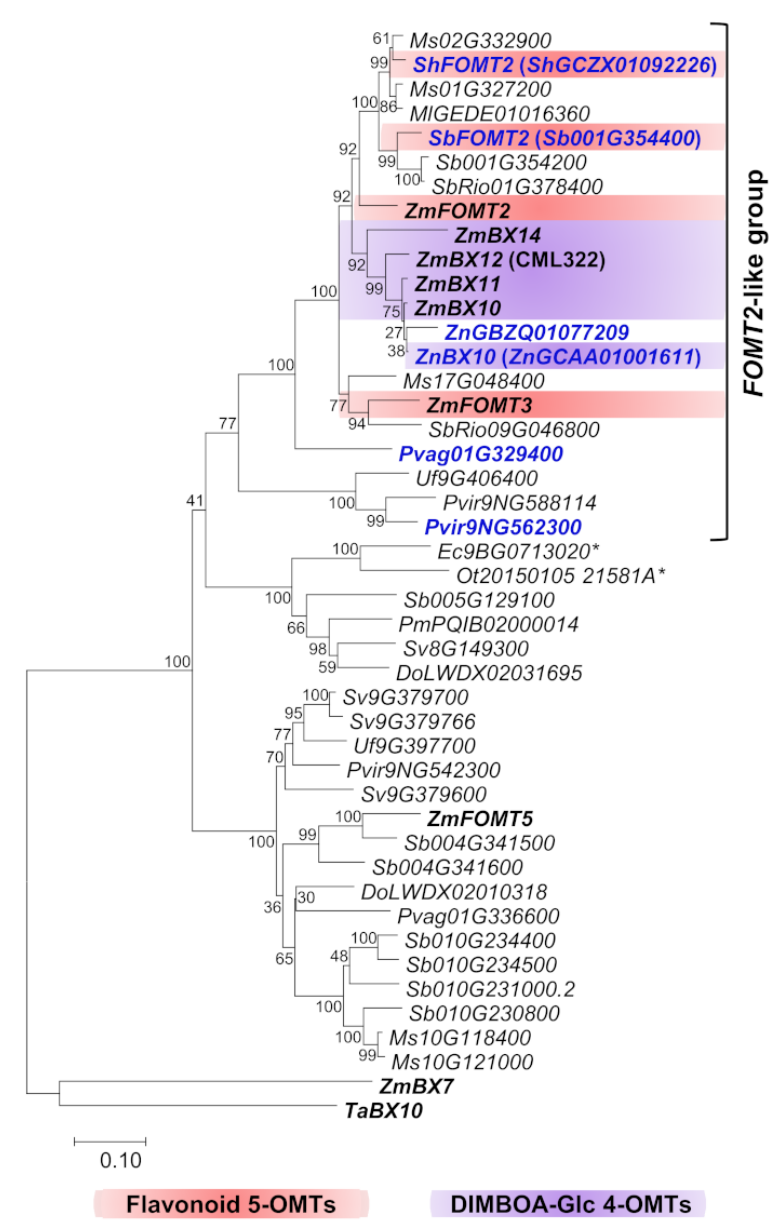
Figure 1. Phylogenetic analysis of putative FOMT and BX OMT genes similar to ZmFOMT2 in diverse species of the Poaceae. The tree represents a subtree (“PACMAD-specific FOMT2-BX10 clade”) of a larger tree given in Figure S1. The tree was inferred using the maximum likelihood method based on the general time-reversible model, including gamma-distributed rate variation among sites (+G, 1.2811). Bootstrap values ( n = 1000) are shown next to each node. The tree is drawn to scale, with branch lengths measured in the number of substitutions per site. All positions with < 80% site coverage were eliminated. ZmBX7 ( Zm00001d049179 ) and TaBX10 ( 4AL_C467B516F ) were used as an outgroup for rooting. OMTs investigated in this study are highlighted in bold blue text, and previously characterized genes are shown in bold black text. Genes marked with (*) belong to the Chloridoideae subfamily, and all other genes belong to the Panicoideae subfamily.